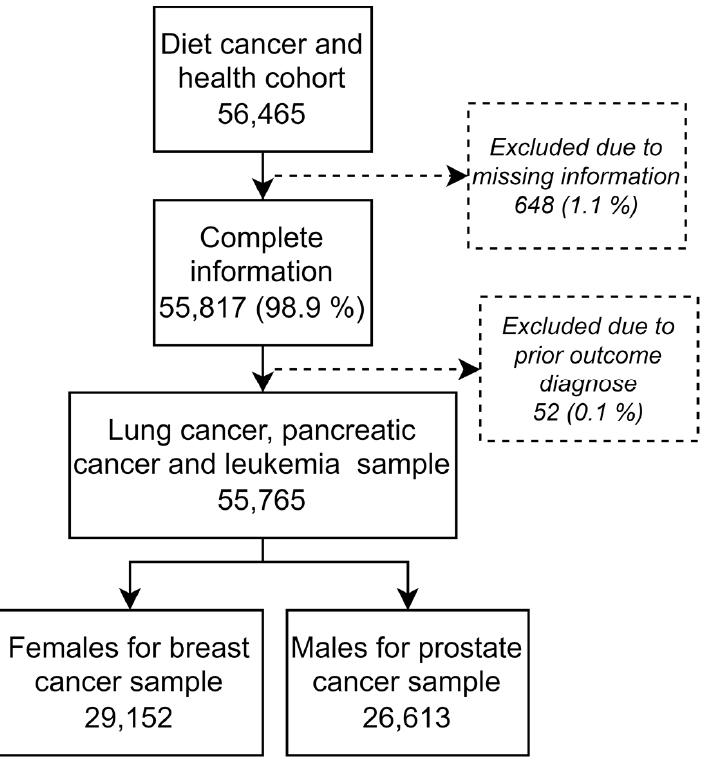
Figure 1. Flow of participants including sample size for each outcome measure. Table 2. Baseline carrot intake by outcomes during follow-up.